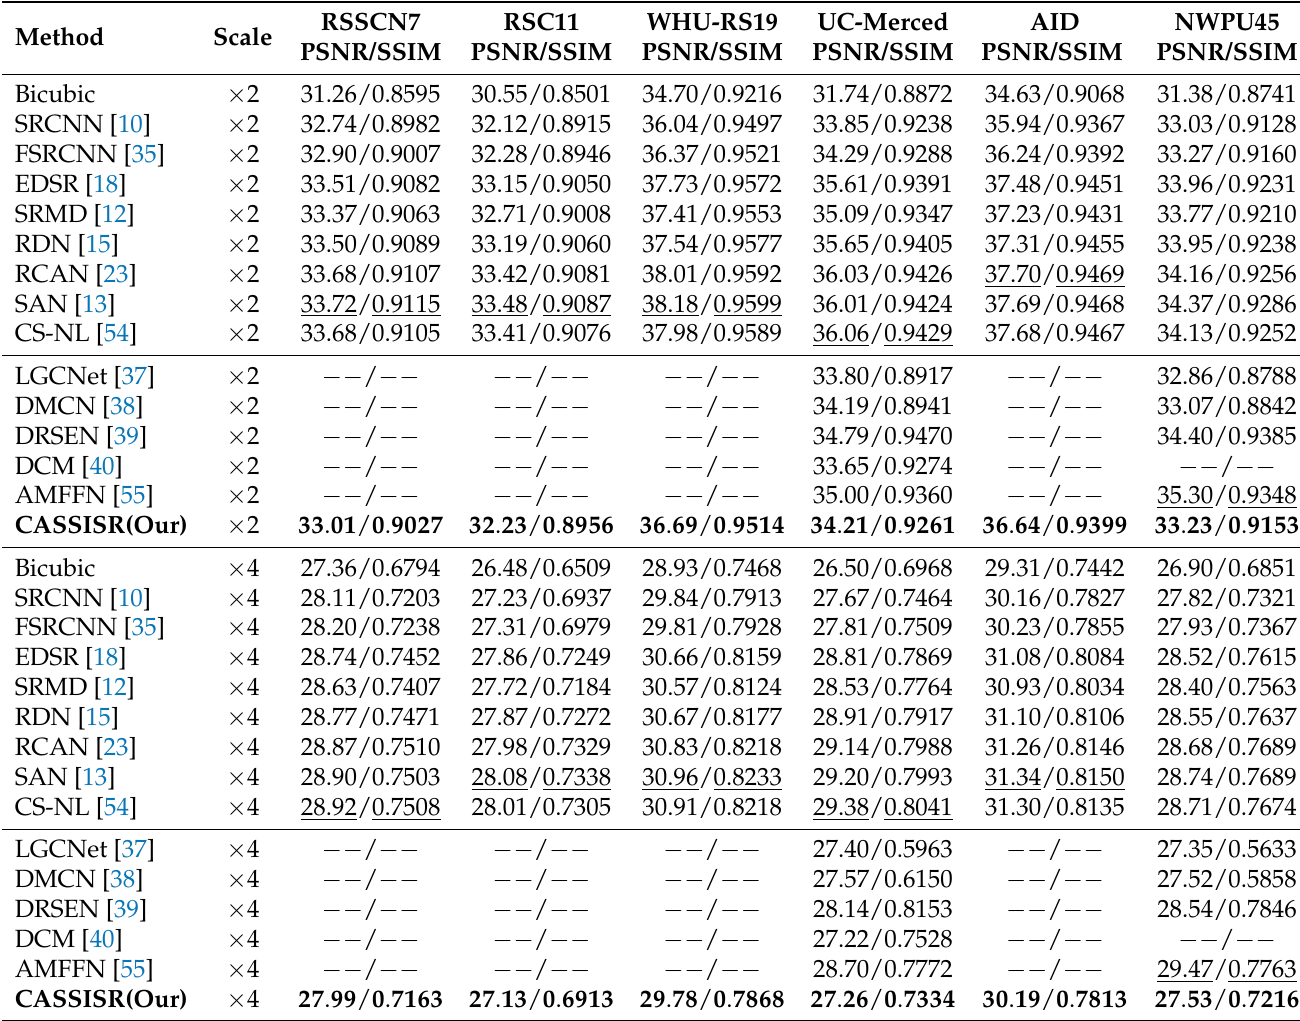
Table 1. The quantitative results of CASSISR, CNN-based SR methods, and remote sensing SR methods on the ‘ideal’ remote sensing dataset (bicubic downsampling). Our CASSISR results are highlighted , and the best results are underlined. Please note that CASSISR only uses one image for training, while other methods are trained on large